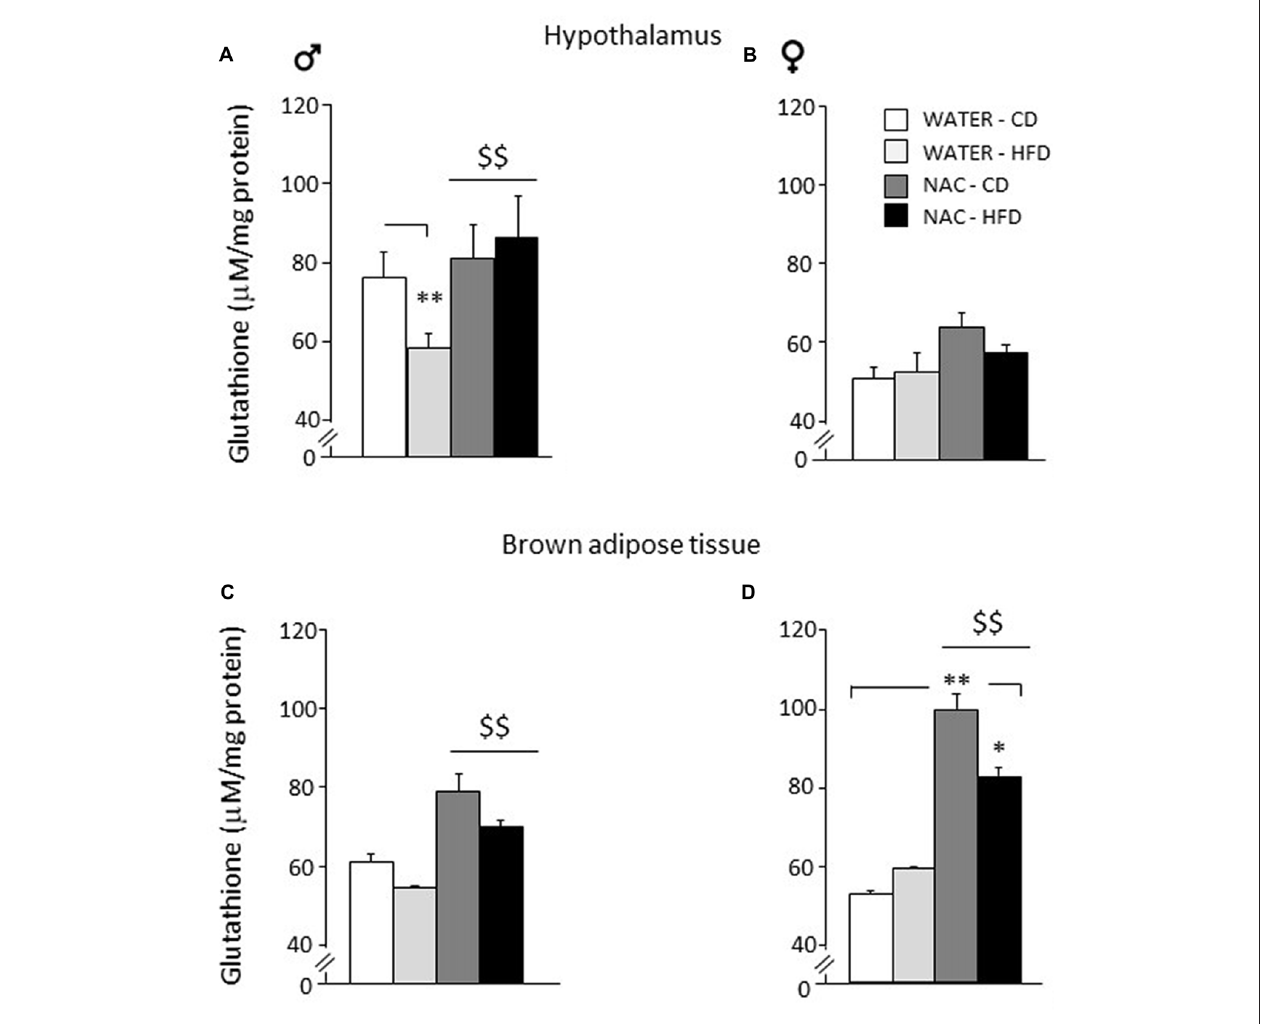
FIGURE 6 | Levels of glutathione in peripheral and central tissues. Hypothalamus: (A) glutathione levels were lowered by diet in male subjects (WATER-HFD). Independently from prenatal HFD, all males showed higher glutathione levels as a result of NAC administration. (B) Females mice showed reduced glutathione levels in this area and appeared to be more resilient to changes either upon HFD or NAC. Brown Adipose Tissue (BAT): (C) Both male and female subjects showed an increase in glutathione levels upon NAC administration. (D) In addition, females show a significant increase in glutathione (NAC-CD) that was reduced upon HFD administration (NAC-HFD). Data are mean + SEM. ∗∗ p < 0.01 for WATER-HFD vs. WATER-CD in male (A) and NAC-CD vs. WATER-CD (D) ; ∗ p < 0.05 for NAC-HFD vs. NAC-CD (D) . $$ p < 0.01 main effect of NAC (A,C,D)